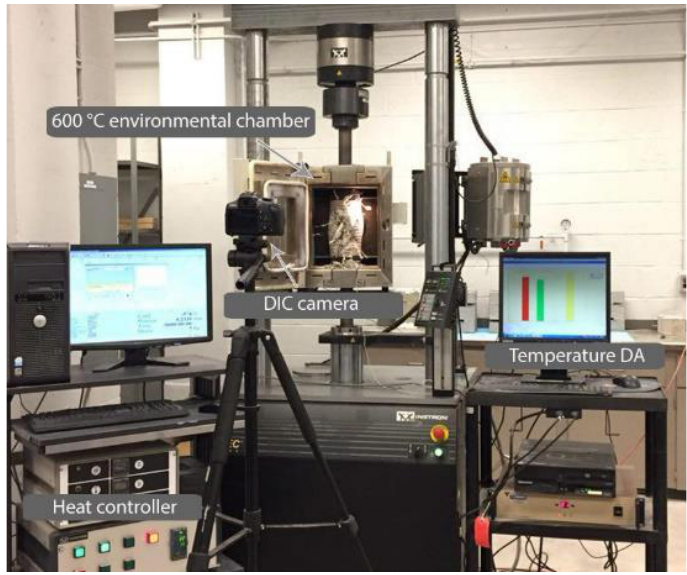
Figure 1 . The test setup at high temperatures [9]. Figure 1. The test setup at high temperatures